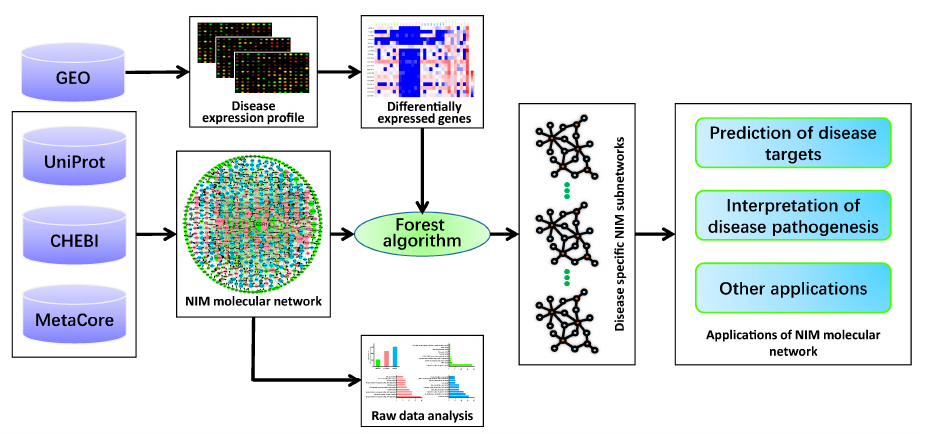
Figure 5. The flowchart for the construction of the NIM molecular network and its application. Firstly, we collected the NIM signaling molecules (including neurotransmitters, neuropeptides, hormones, cytokines, and their corresponding receptors) through retrieval from the UniProt and ChEBI databases. Based on the interactions in the MetaCore database, we constructed the core and the extended network of the NIM signaling molecules and conducted an analysis of the raw data and the core network. Secondly, we obtained the gene expression profile of the disease from the GEO database and screened the differentially expressed genes (DEGs). Then, we extracted the disease-specific NIM subnetworks from the extended network of NIM signaling molecules using the forest algorithm. Finally, we took the RA- and AD-specific NIM subnetworks as an example to show the application of